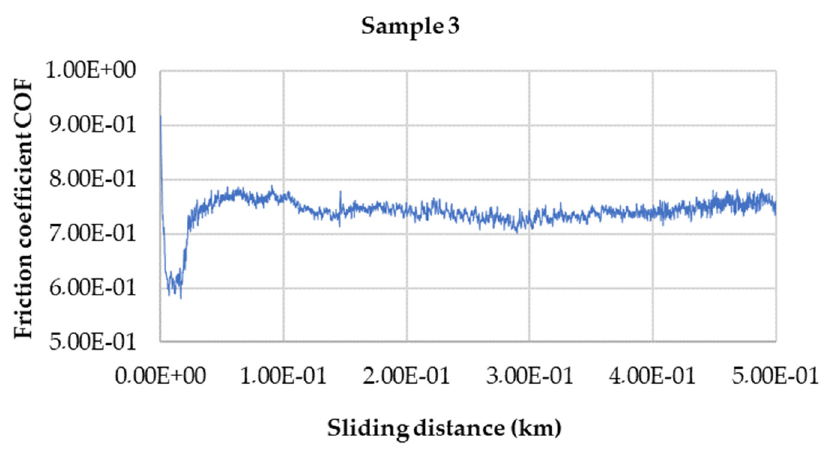
Figure 7. Course of COF for Ni-Co coatings (Sample 2) deposited at 2 A dm − 2 .